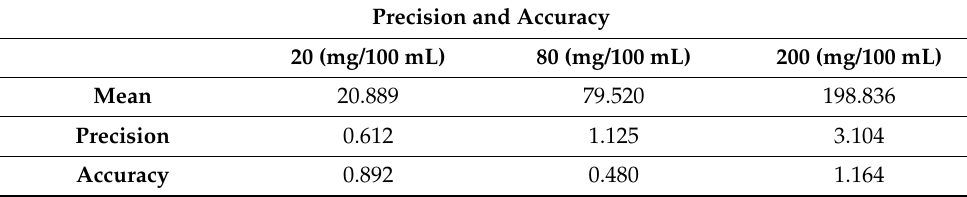
Table 2. Summary of the precision and accuracy of the validation results from 11 batches in mg/100 mL. No significant differences were found at 80 and 200 mg/100 mL—the two limits critical in road traffic toxicology